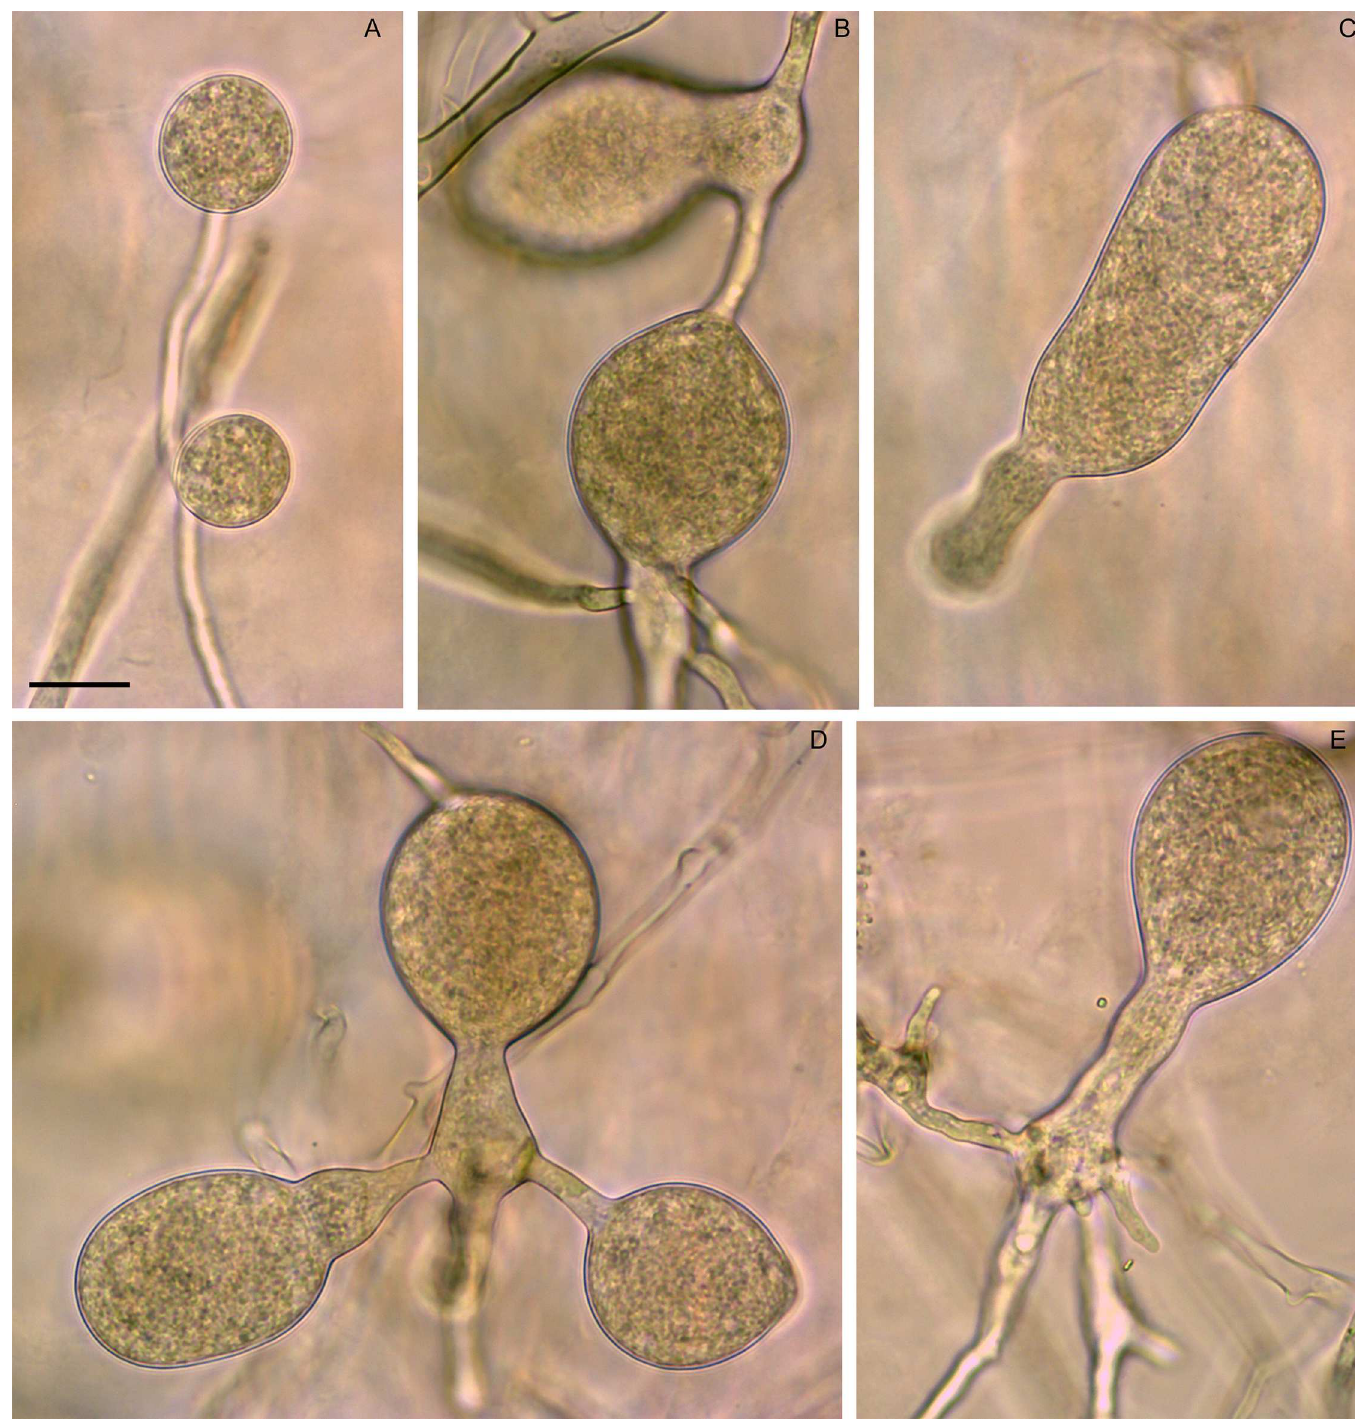
Fig 4. Chlamydospores and hyphal swellings produced by P . sp. prodigiosa. (A). Globose, small, sessile chlamydospores on V8A, attached laterally to the hyphaand with a thin wall. (B-E) Hyphalswellingsof P . sp. prodigiosa on V8A with bizarre shapes (Scale bar = 20 μ m).